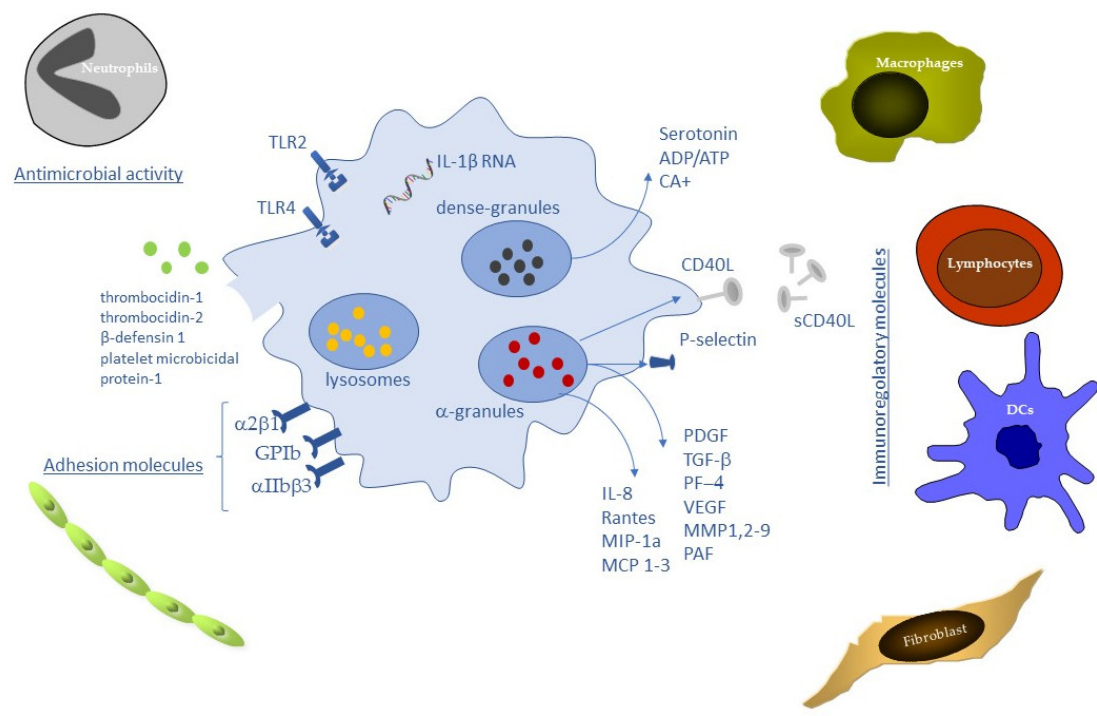
Figure 1. Platelet biomolecules during wound healing